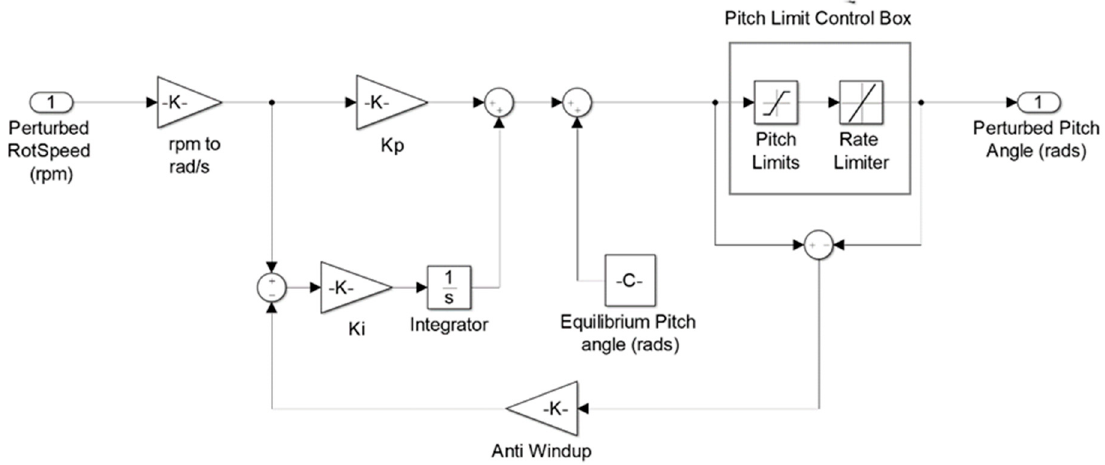
Figure 2. Pitch-to-Stall proportional-integral (PI) controller for the “Pitch-to-Stall Model” and all “Back Twist Pitch-to-Stall Models”.